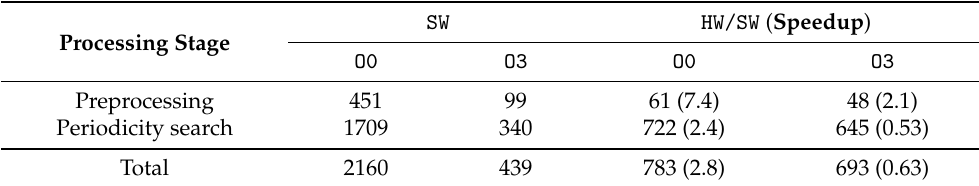
Table 3. Execution times ( µ s) obtained by software-only and HW/SW implementations of the PPG sub-system.